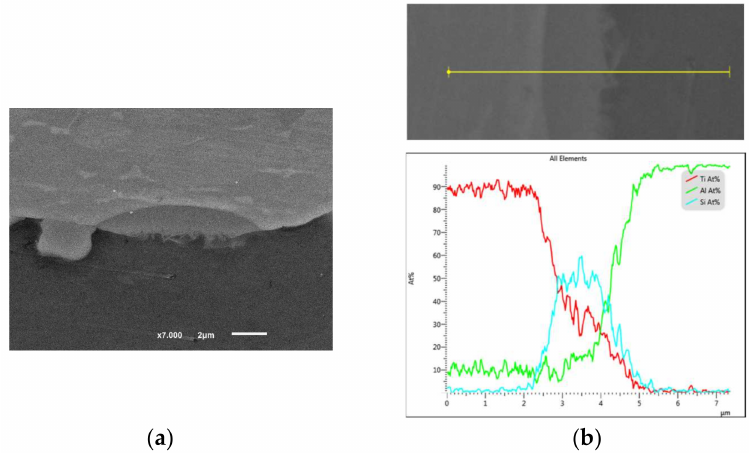
Figure 13. ( a ) SEM image (SEI) of a single pit at the joint interface with the active part, using Al-13Si filler alloy at 585 ◦ C, brazed with USV only (13/585U); ( b ) EDS line analysis across the pit.